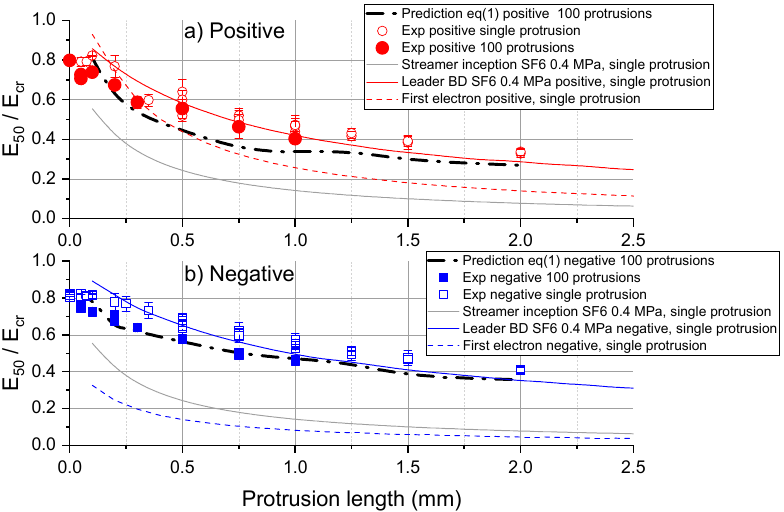
Figure 8. Normalized breakdown fields E 50 / E cr vs. protrusion length L for SF 6 and 100 protrusions. Not all protrusion lengths could be measured when using multiple protrusions at ( a ) positive and ( b ) negative polarities.